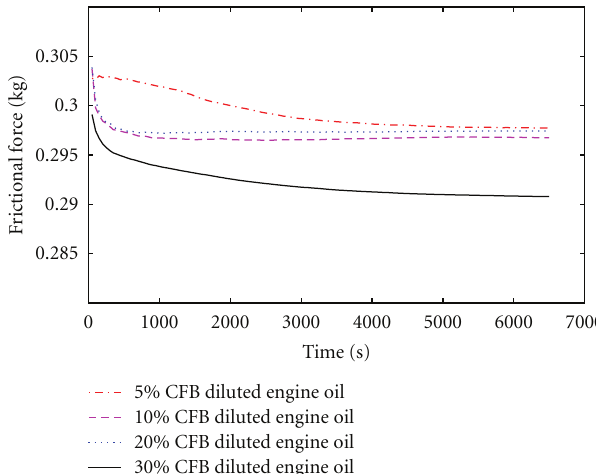
Figure 7: Friction force versus time for soybean-oil biodiesel diluted engine oil mixtures.